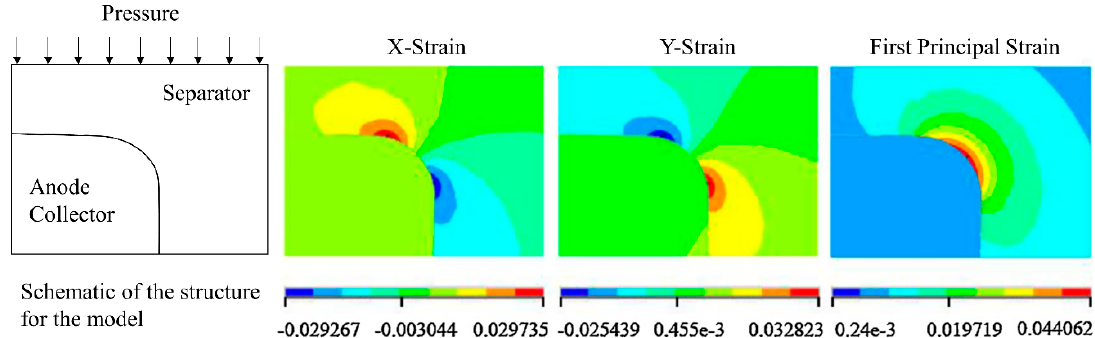
Figure 3. Schematic and contours of strain [m m − 1 ] components in the separator near the corner [31].